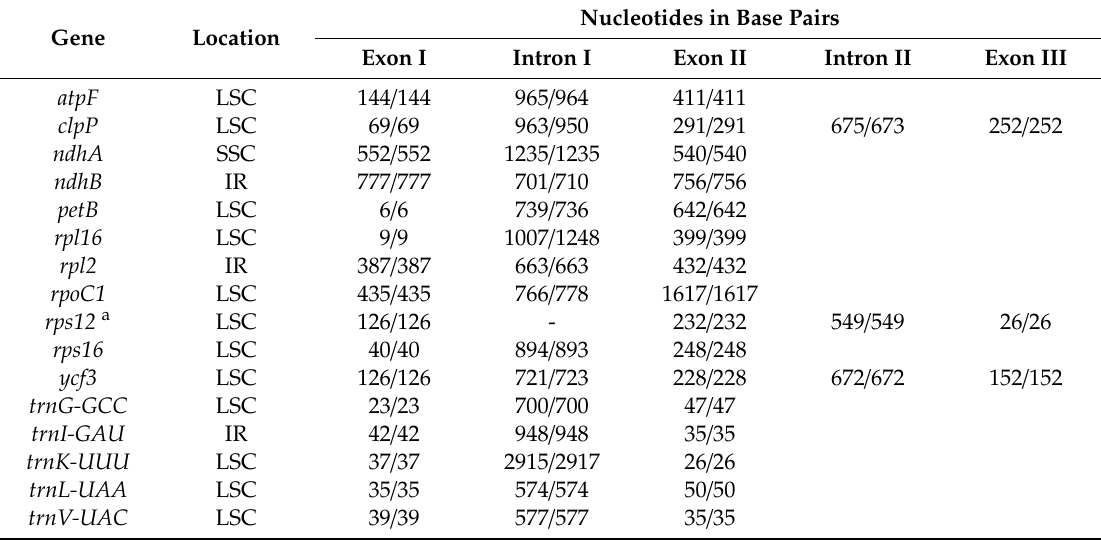
Table 3. Location and Length of Intron-Containing Genes in the Coelogyne Chloroplast